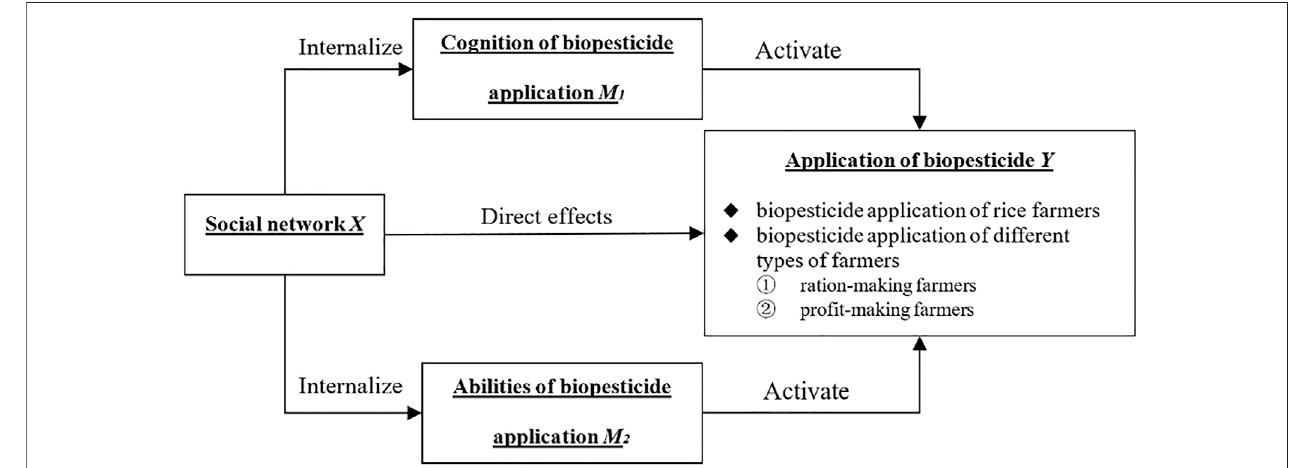
FIGURE 1 | Theoretical